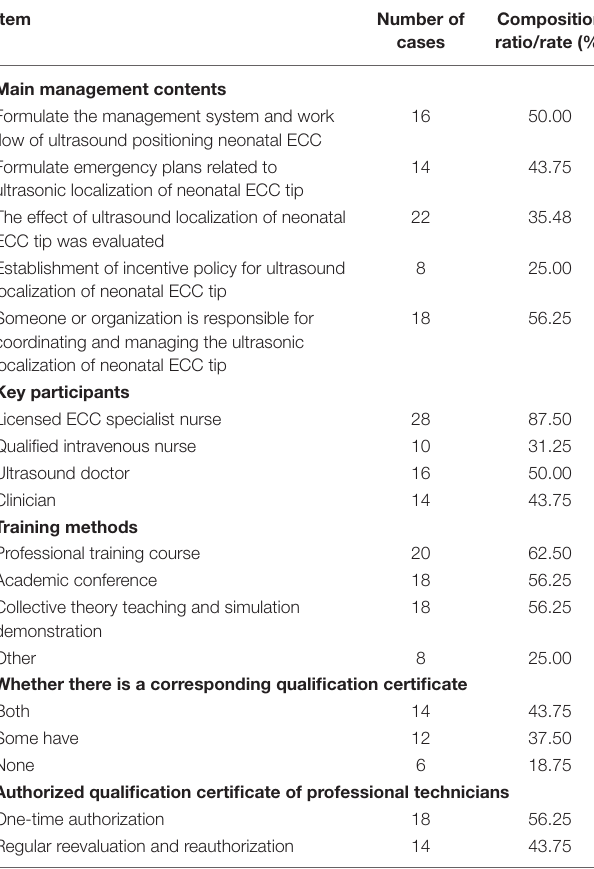
TABLE 5 | Management work of the hospital for the implementation of neonatal ultrasound localization [institute (%)].